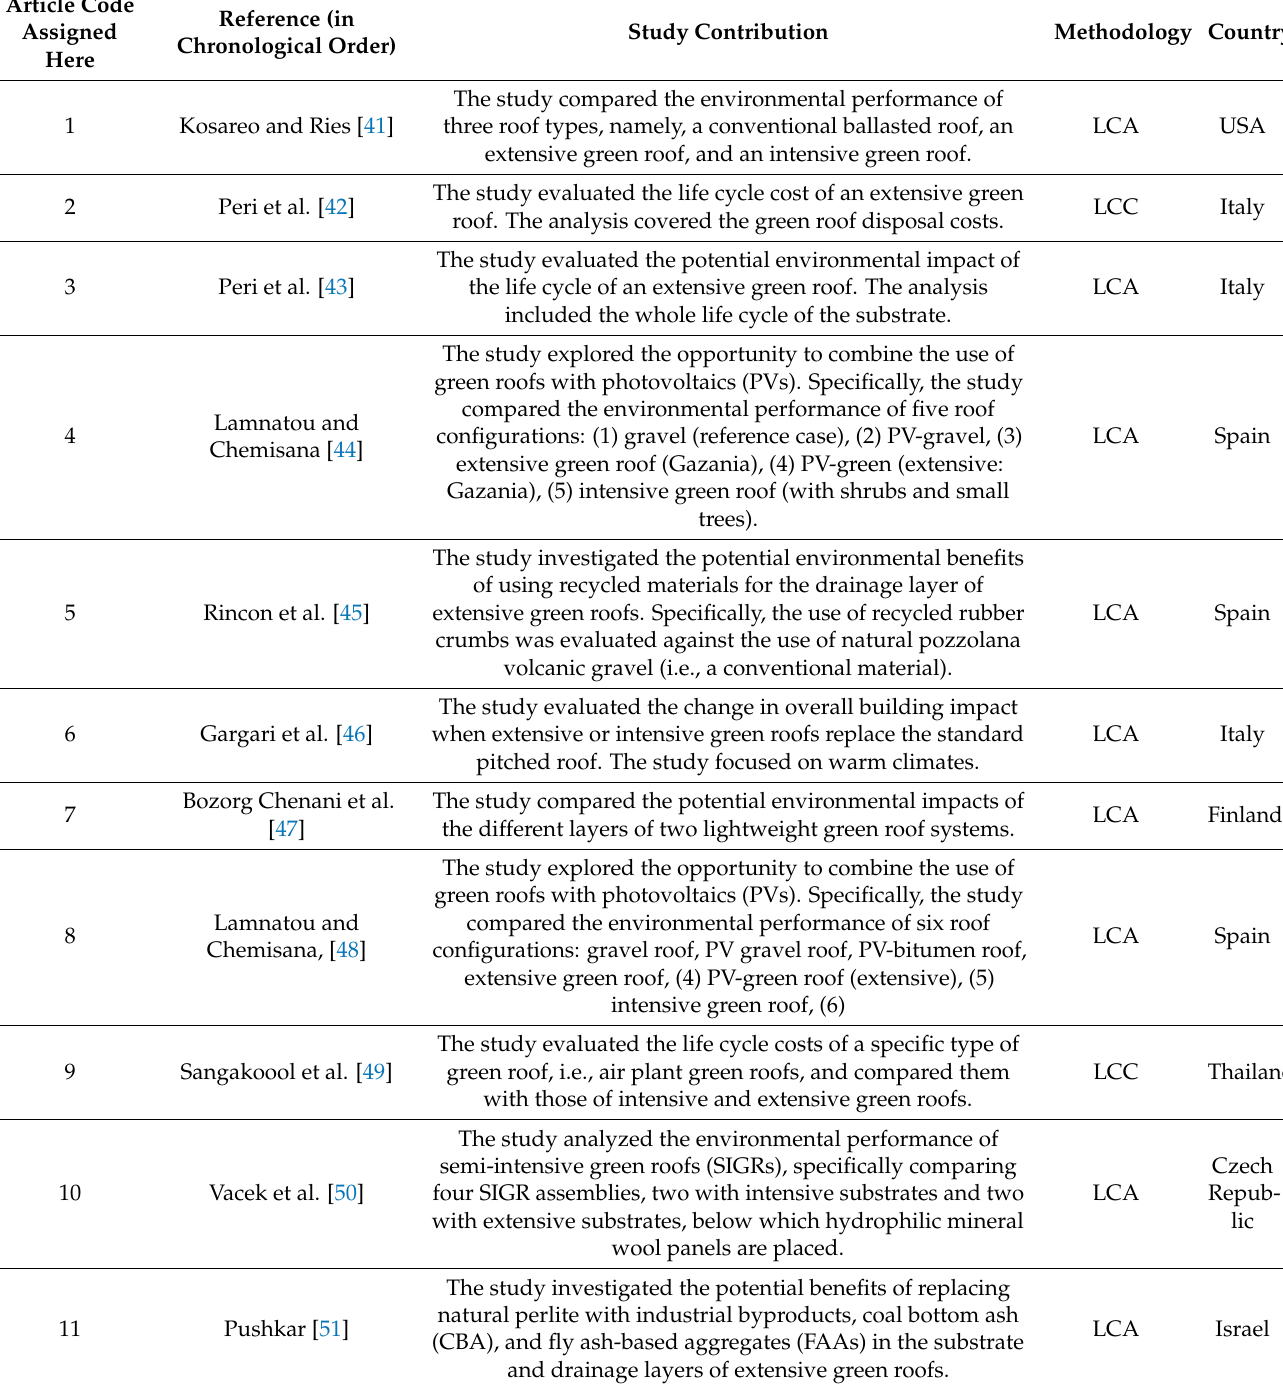
Table 3. General information on the eleven analyzed original research articles dealing with the end-of-life of green